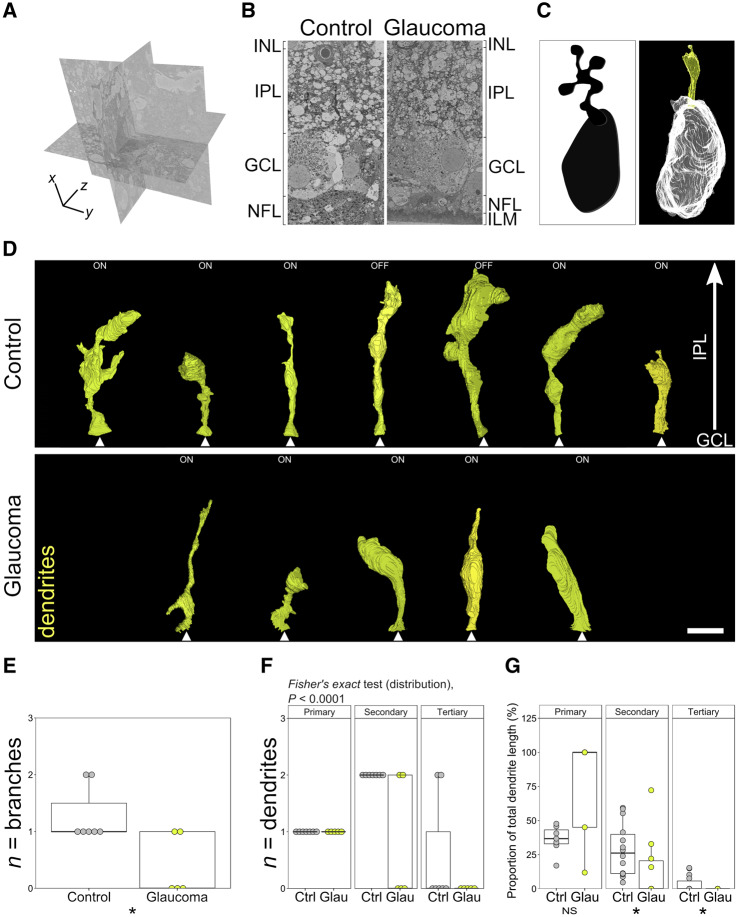

Dendritic loss is a feature of human glaucoma. Retinal samples [n = 5 from glaucoma (four eyes) and n = 6 from controls (four eyes) corresponding to visual field test locations were dissected and prepared for SBFSEM]. Volumetric EM data were generated (A) from 79 × 79 × 100 µm tissue cube (19.2 × 19.2 × 100 nm resolution). A representative single slice (x–y plane) is shown in B (cropped in x), showing the retinal layers analysed. Retinal ganglion cells were identified, and their dendrites were reconstructed within the IPL. A cartoon of a Golgi-stained midget cell is shown for comparison in C alongside a reconstruction from the current SBFSEM data (for more examples see Kolb and Dekorver, 1991). Seven control (D, upper panel) and five glaucomatous (D, lower panel) retinal ganglion cells that met inclusion criteria were reconstructed. Dendrites (yellow) and synapses (cyan) are shown, with the dendrite origin at the soma indicated (white arrowheads). Analysis of dendrites demonstrated reduced dendritic branching (E) and fewer and shorter secondary and tertiary dendrites in glaucoma, indicating the presence of dendritic atrophy (F and G; primary dendrites n = 5 in glaucoma, n = 7 in controls; secondary dendrites n = 4 in glaucoma, n = 14 in control; tertiary dendrites n = 0 in glaucoma, n = 3 in control). *P < 0.05, NS = non-significant (P > 0.05). For B, ILM = inner limiting membrane, NFL = nerve fibre layer, GCL = ganglion cell layer, IPL = inner plexiform layer, INL = inner nuclear layer. Scale bar = 5 μm for D.